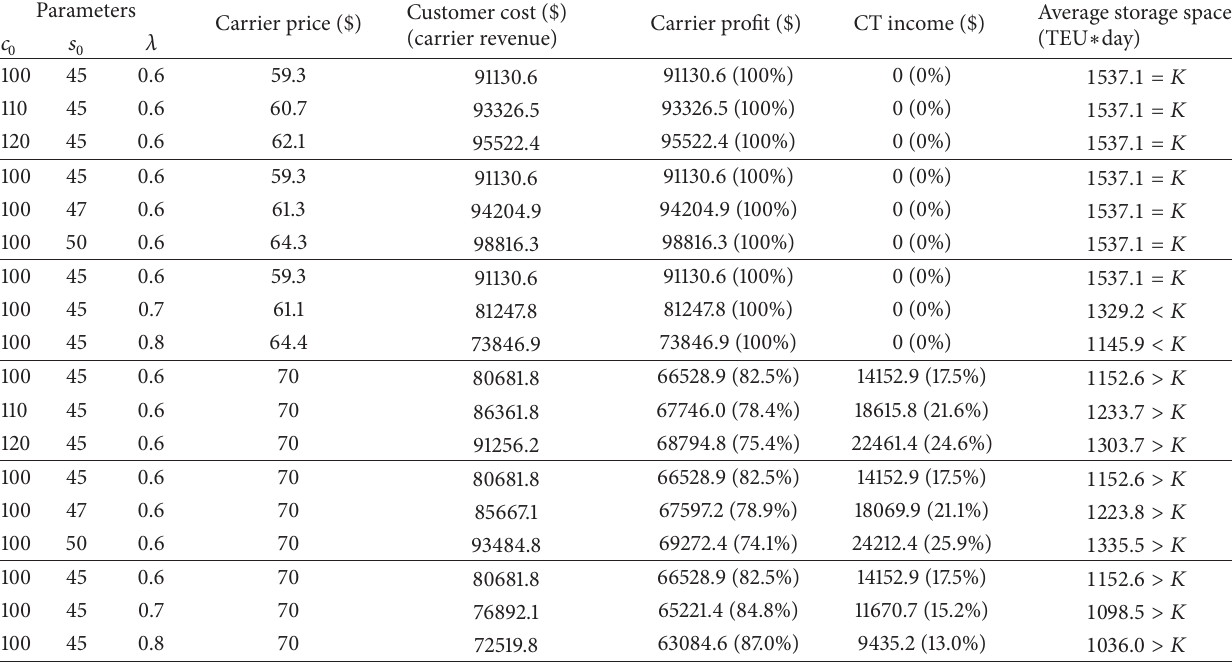
Table 4: Sensitivity analysis of free-space system under different 𝑐 0 , 𝑠 0 , and 𝜆